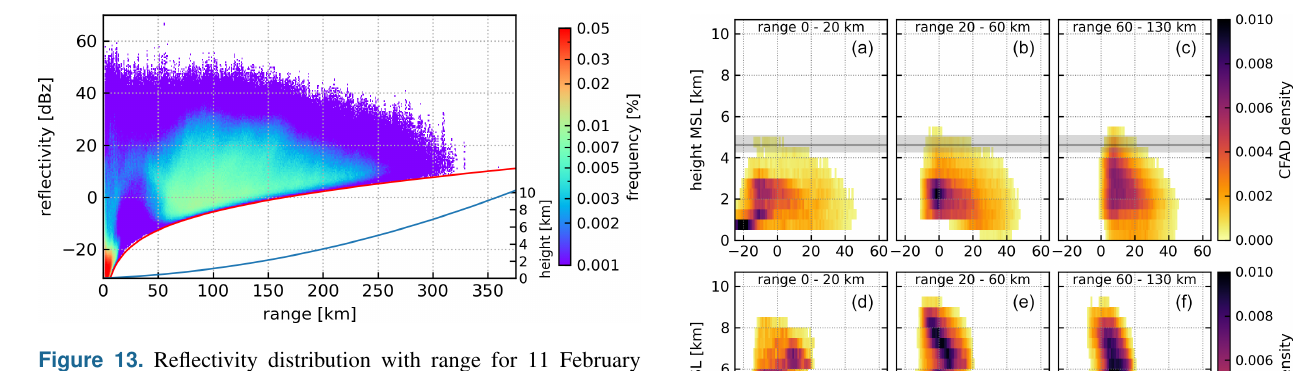
Figure 13. Reflectivity distribution with range for 11 February 2020 from long-range measurements. Red line indicates minimum detectable signal (MDS) as given by Eq. (1). Blue line indicates height of beam center above sea level.